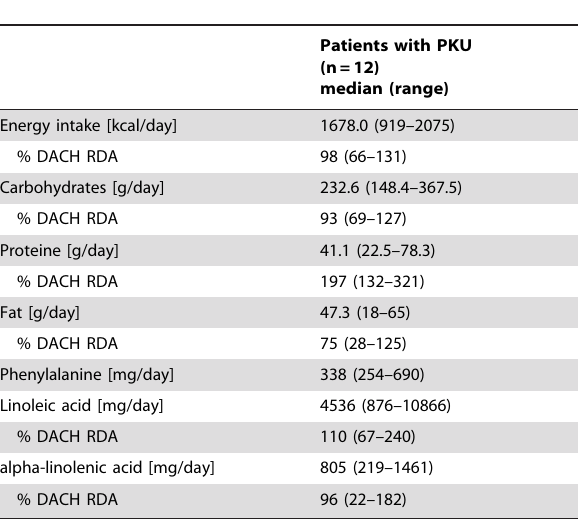
Table 1. Analysis of three-day diet record of patients with phenylketonuria